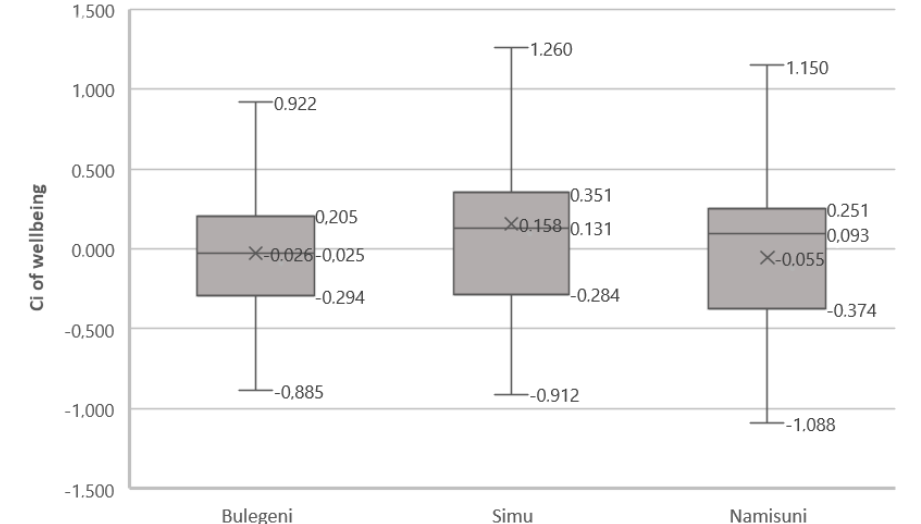
Figure 3. Bloxplots depicting the CI of wellbeing by sub-county.